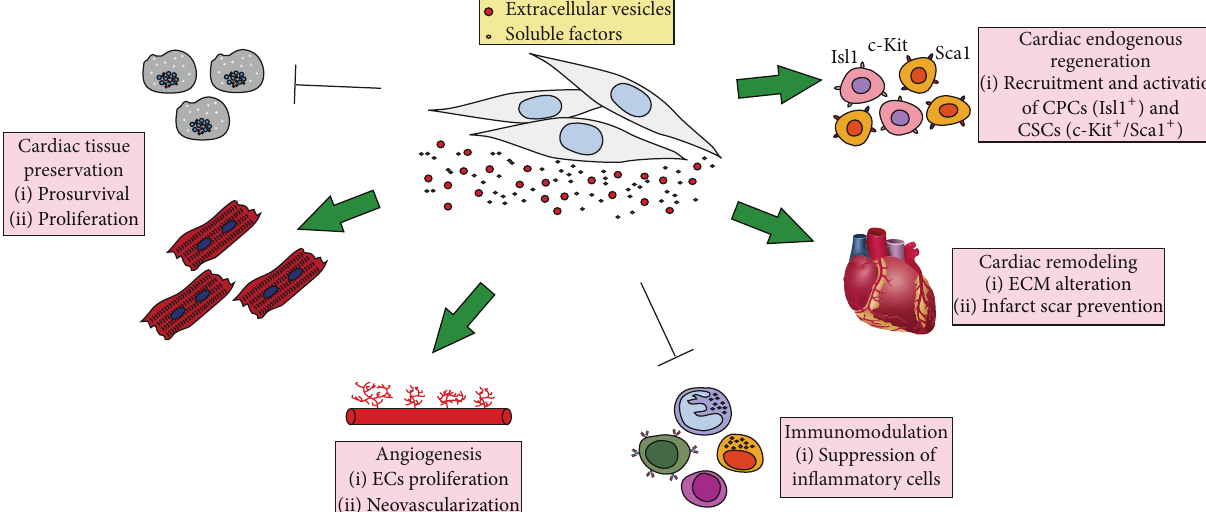
Figure 1: The broad repertoire of MSCs secretome has considerable potential for the treatment of CVD . In the context of myocardial protection, potential therapeutic mechanisms established by MSCs secretome include tissue preservation, angiogenesis, beneficial cardiac remodeling, anti-inflammatory responses, and finally promotion of endogenous regeneration of the heart. CPCs: cardiac progenitor cells; CSCs: cardiac stem cells; ECs: endothelial cells; ECM: extracellular